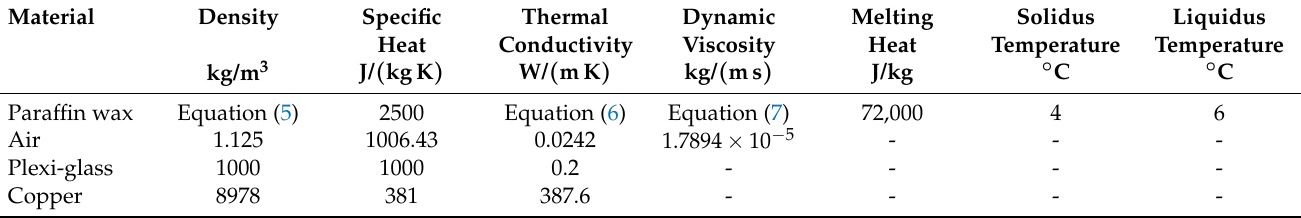
Table 4. Thermophysical properties of materials used during